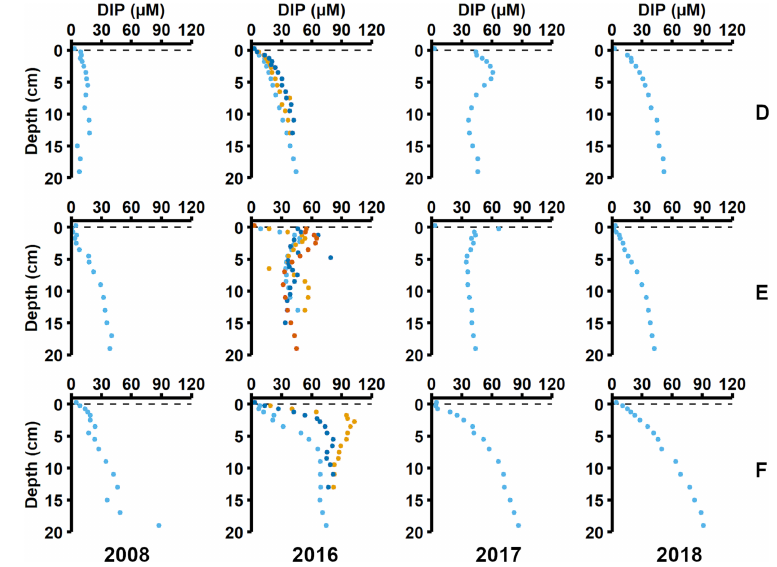
Figure A3. Pore water profiles of dissolved inorganic phosphorus (DIP). Profiles from 2008 are from Viktorsson et al. (2013). Different colours show replicate cores (same as Table C1): light blue markers show core 1, orange markers show core 2, dark blue markers show core 3, and red markers show core 4.